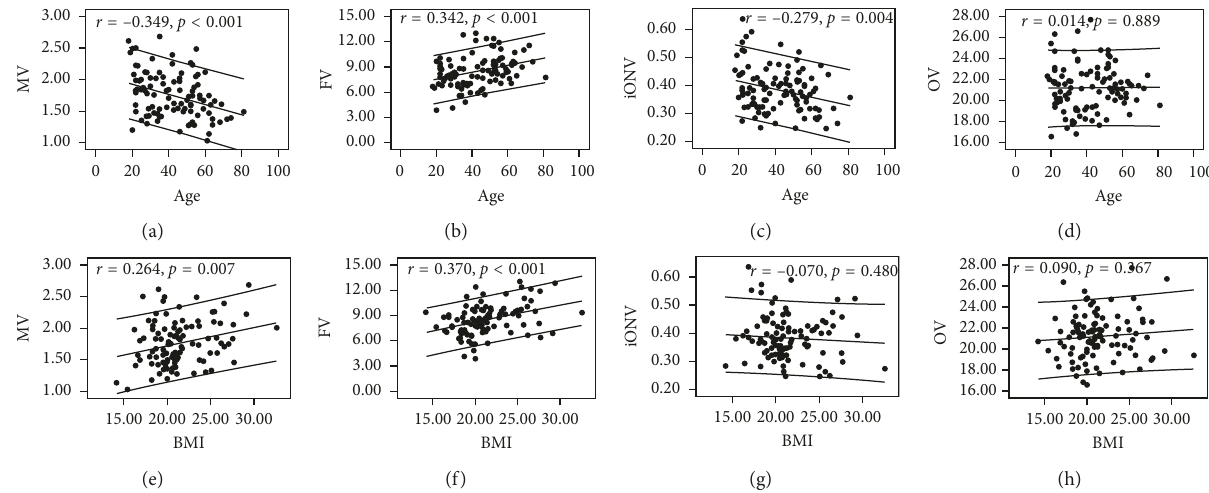
Figure 2: Scatterplots showing correlations between MV, FV, iONV, OV, and age, respectively (a-d), and correlations between MV, FV, iONV, OV, and BMI, respectively (e-h). FV, fat volume; iONV, intraorbital optic nerve volume; MV, muscle volume; OV, orbital bony cavity